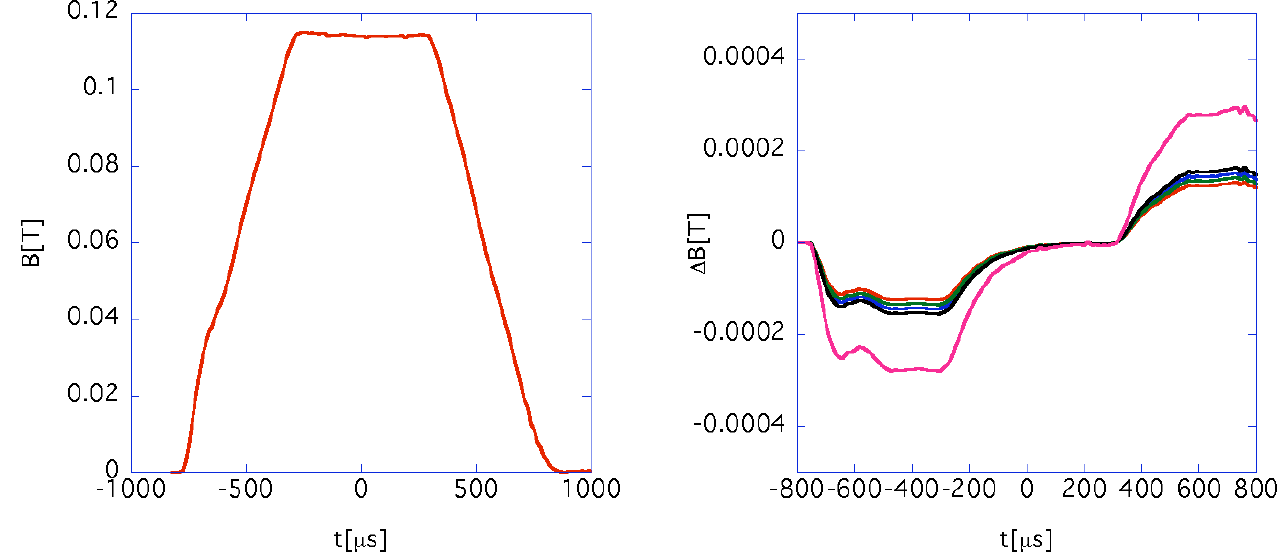
FIG. 16. (Color) The left figure represents the magnetic field pattern, which is used at the injection period with the 3 GeV RCS at J- PARC (measured data). The right figure represents the field modulation (theoretical results) at the center of the chamber when this (measured) magnetic flux traverses the Cu stripe. The red, blue, green, black, and pink lines represent the cases where 20, 40, 60, 80, and 100 stripes cover the chamber from the lower